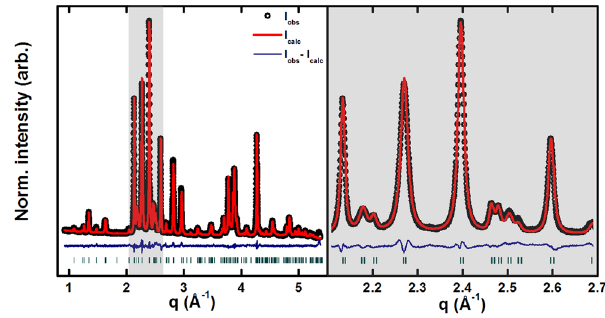
Figure 2. PXRD patterns and Rietveld refinements of SrFe 12 O 19 nanocrystallites prepared from the Fe 3 + :Sr 2 + molar ratio 9 (MSG9). To the right a zoom of the data between 2.1 and 2.7 Å − 1 is shown.